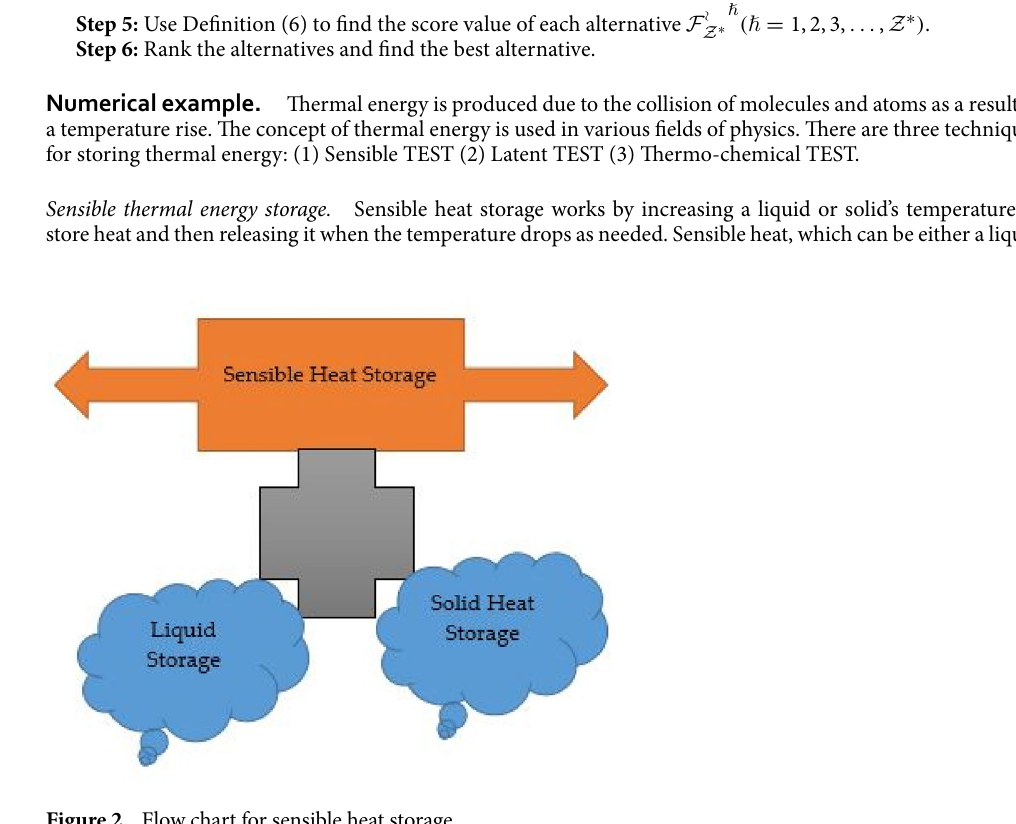
Figure 2. Flow chart for sensible heat